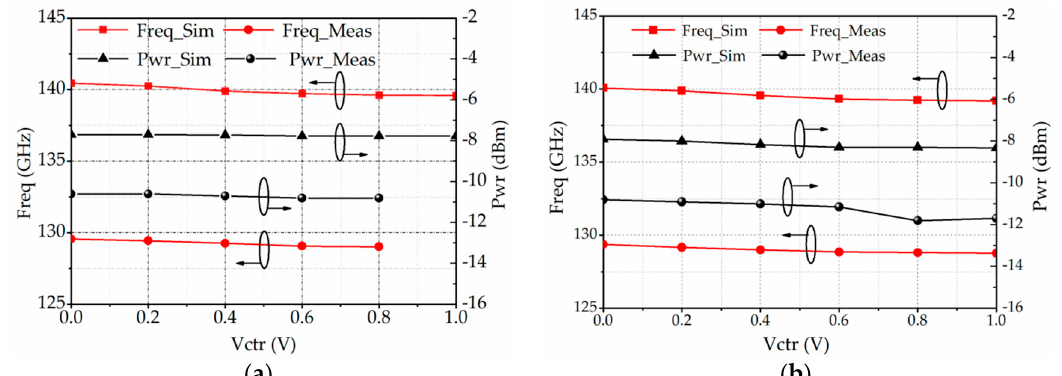
Figure 14. The simulated- and measured-frequency range and output power when the switch was on ( a ) and off ( b ).